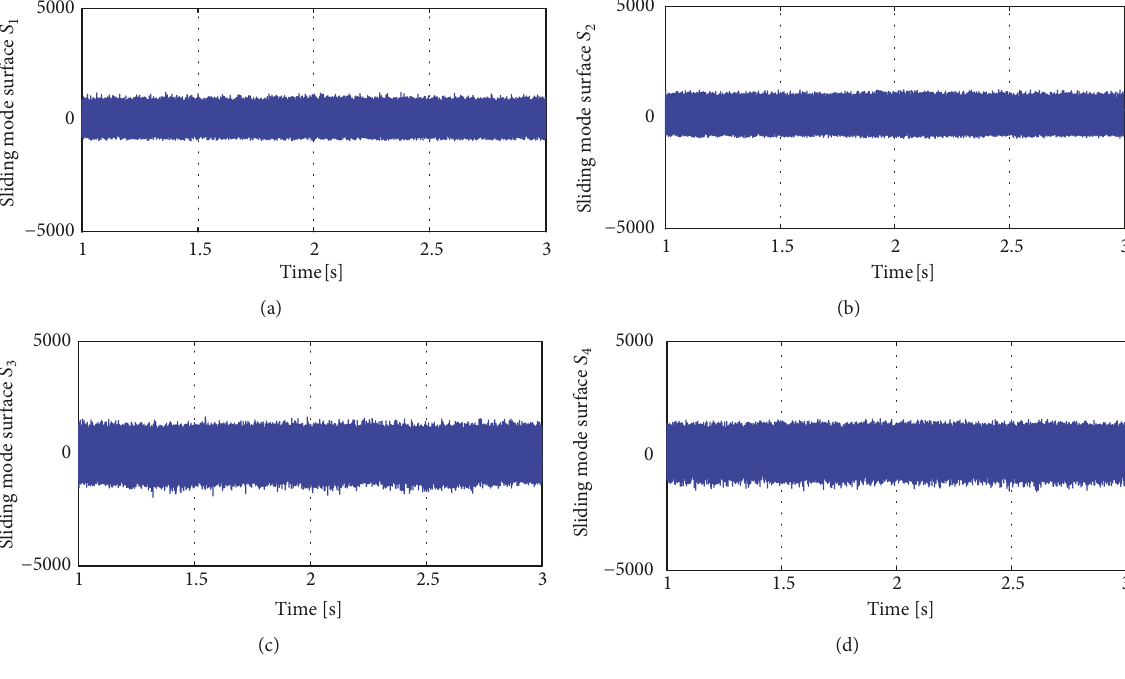
Figure 7: Sliding mode surface